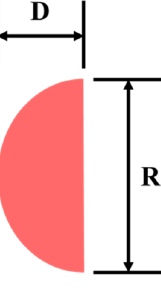
Figure 9. Definition of width 𝐷 and height 𝑅 for laser spot image.